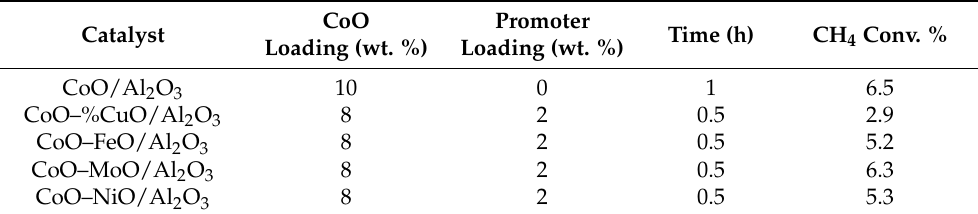
Table 3. The catalytic activity of cobalt catalysts including different promoters and tested at 700 ◦ C and 1 atm [38].